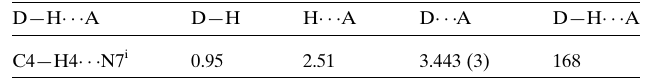
Table 1 Contact geometry (A˚ , (cid:3) ).